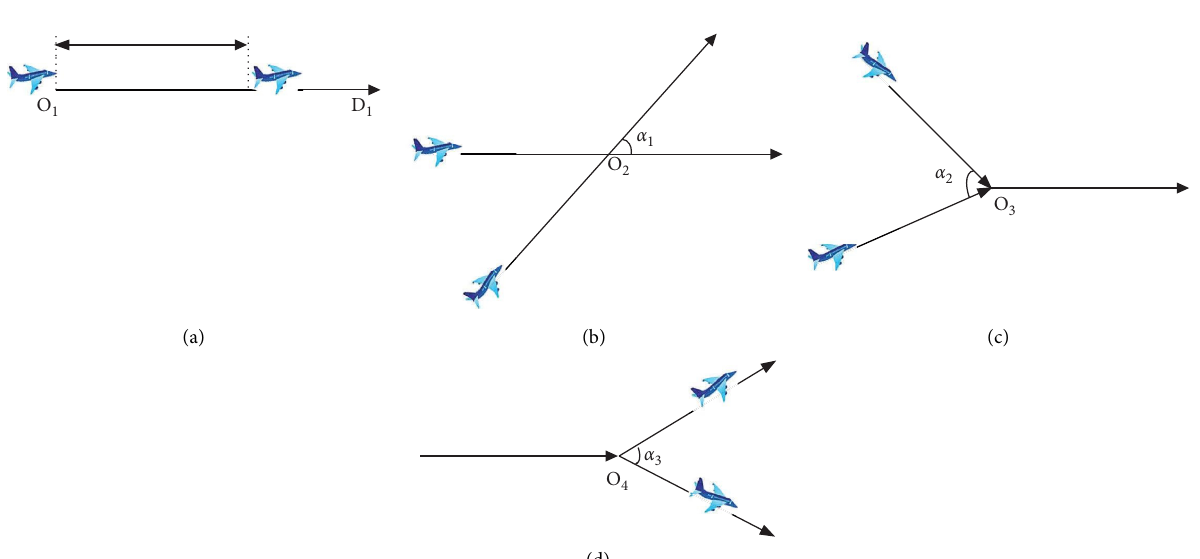
Figure 2: Te basic structure of air routes. (a) A linear air route. (b) Cross-air routes. (c) Convergent air routes. (d) Divergent air routes.